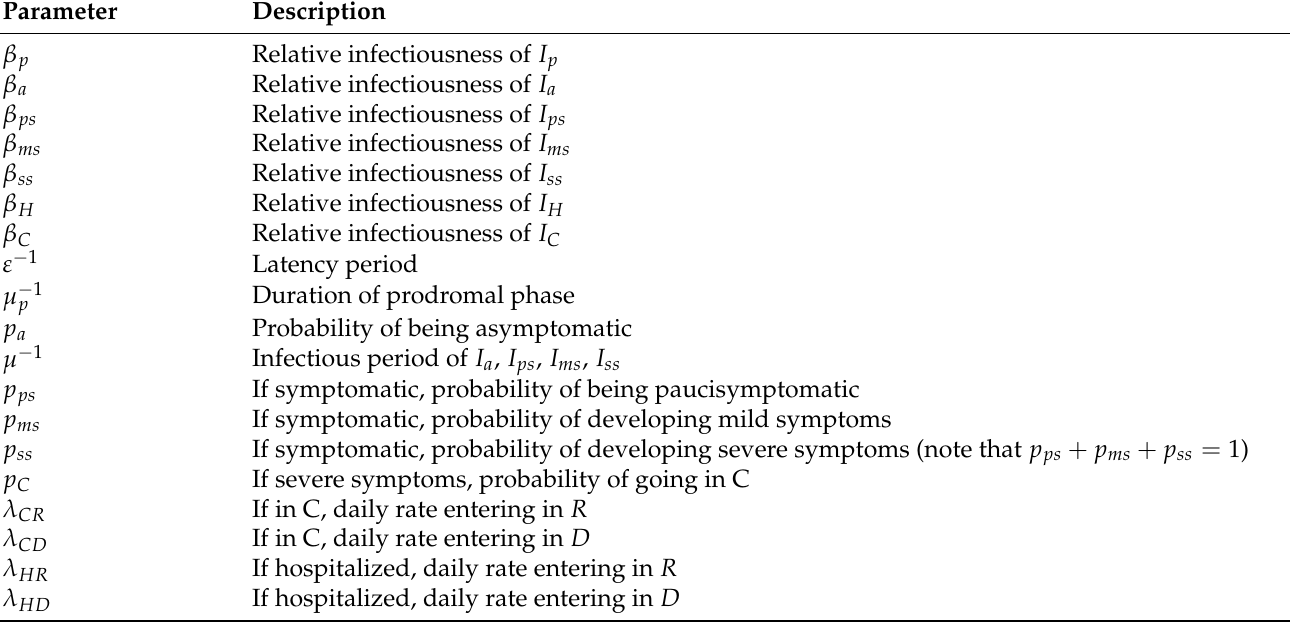
Table 2. Description of the parameters involved in Model SEI 5 CHRD